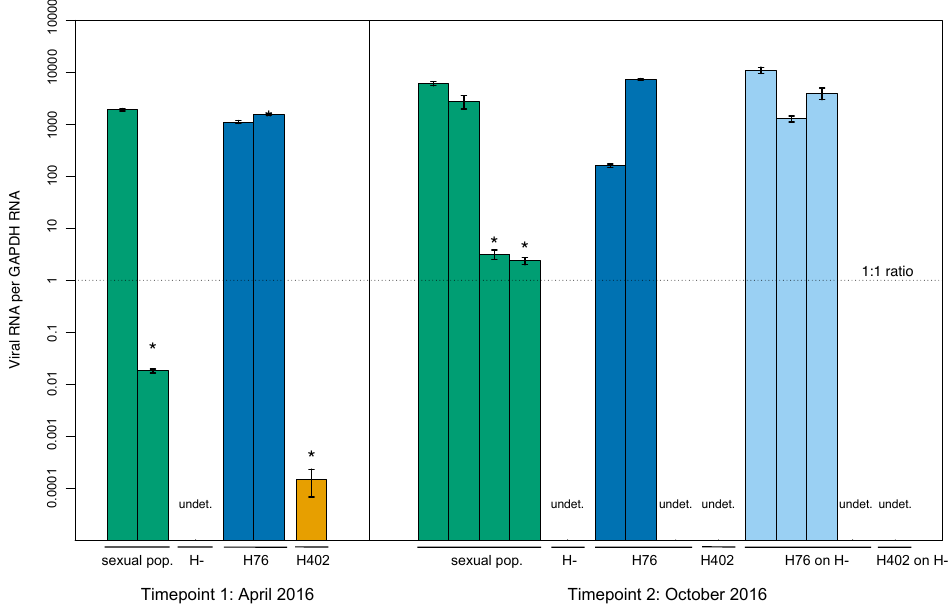
Figure 2. Lab population samples tested with qPCR. Bars show the viral loads of individual wasps per GAPDH ± standard error on a log scale. Virus was detected in all lines except H– and H402 on H– (only one undetected sample each shown). The amount of viral RNA in samples varies highly. Asterisks show samples that were negative based on PCR but show viral presence based on qPCR. The dashed horizontal line shows where the number of viral and GAPDH transcripts are equal and samples with no viral detection are labelled with “undet.”. Colors depict the di ff erent lines as follows: sexual population (green), H76 (blue), H402 (orange), and H76 on H– (light